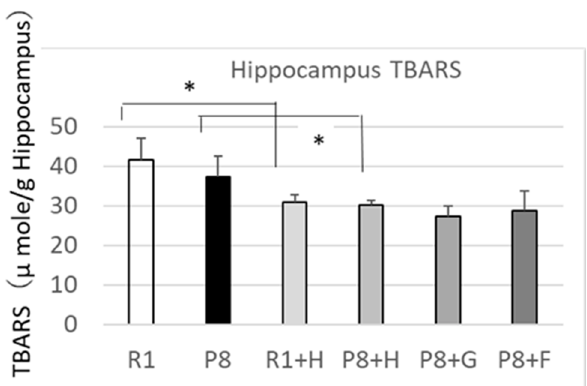
Figure 4. Effect of dietary peanut, germ-rich fraction, and ferulic acid on the hippocampus TBARS in SAMP8. R1: senescence-accelerated resistant mice (SAM-R1) group fed with basal diet; P8: senescence-accelerated mouse prone/8 (SAMP8) group fed with basal diet; R1 + H: SAM-R1 group fed with basal diet with added peanut wholegrain; P8 + H: SAMP8 group fed with basal diet with added peanut wholegrains; P8 + G: SAMP8 group fed with basal diet with added germ-rich fraction of peanut wholegrain; P8 + F: SAMP8 group fed with basal diet with added ferulic acid. * di ff erences between the two groups were significant when compared by the Student’s t -test ( p < 0.05). TBARS: Thiobarbituric acid reactive